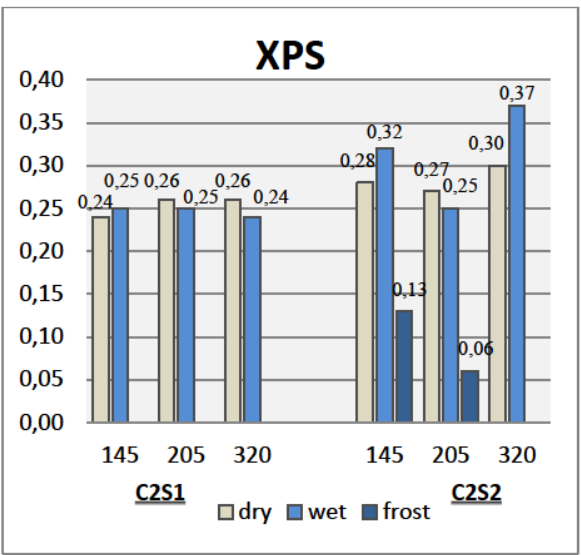
Figure 7: Average results of the pull-off method; comparing the same XPS insulation to different mesh & adhesive & conditions